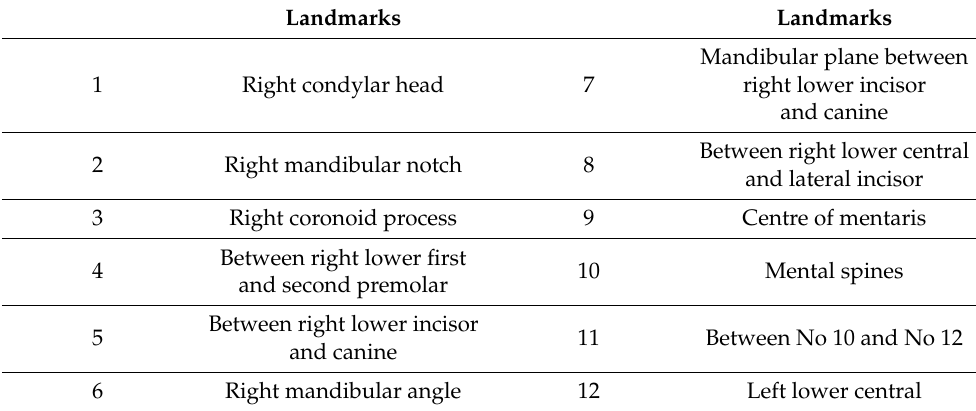
Table 2. The anatomical landmarks in half